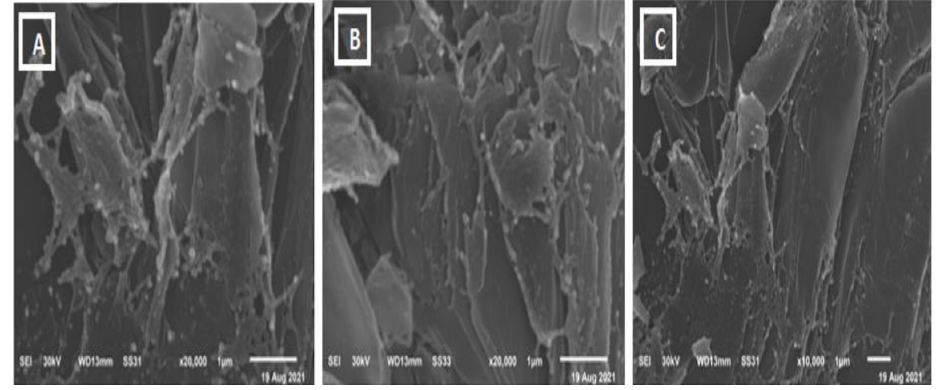
Figure 5. SEM MoO 3 -NPs ( A – C ).